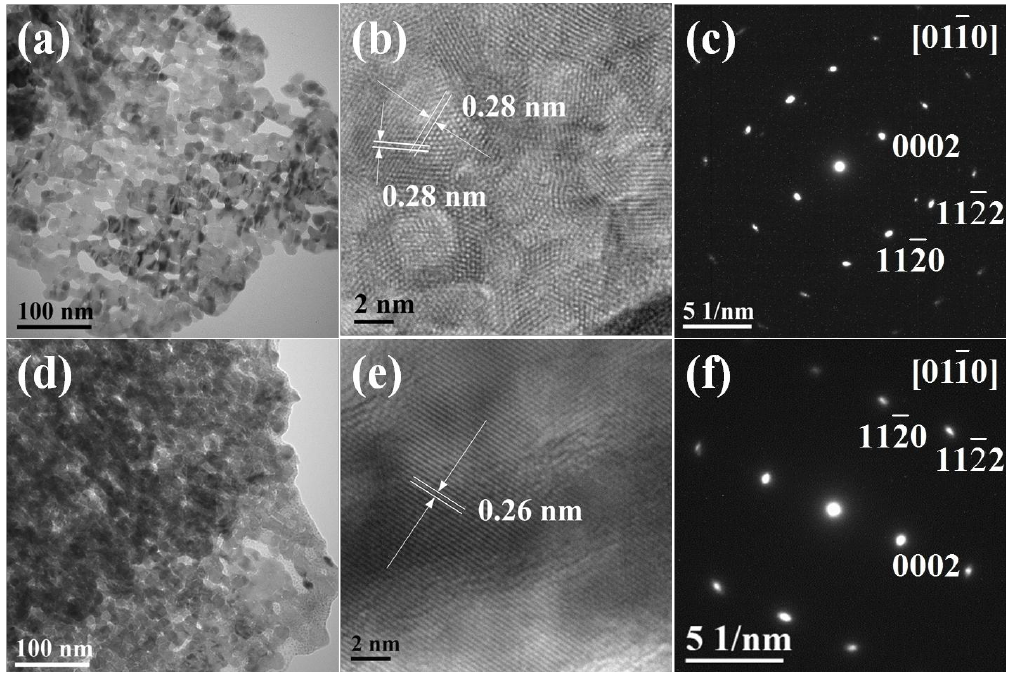
Figure 4. ( a , d ) TEM images, ( b , e ) HR-TEM images and ( c , f ) SAED patterns of ZnO samples F3 and F5,